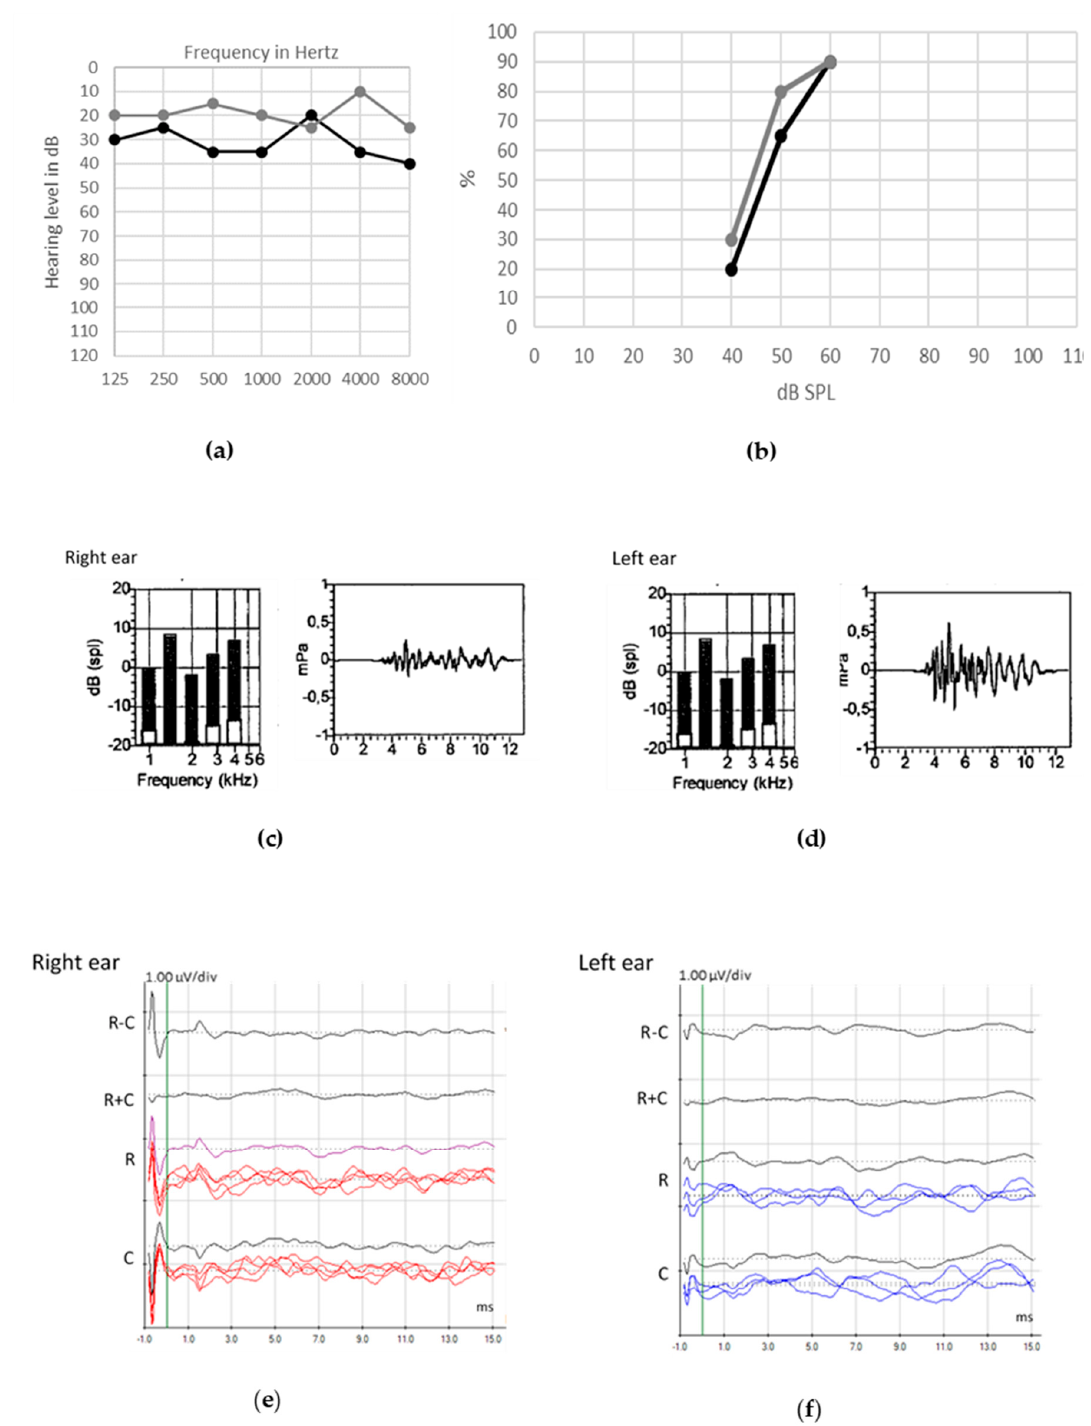
Figure 4. Audiological assessment in an adult patient with auditory neuropathy spectrum disorder (ANSD) and bilateral cochlear nerve atrophy. Unaided thresholds for pure-tone audiometry (( a ), black line for right ear, gray line for left ear) and speech audiometry (( b ), black line for right ear, gray line for left ear) in quiet are good. Otoacoustic emissions (OAEs) are present bilaterally in both temporal/intensity recordings (left panel in ( c ) for right ear, left panel in ( d ) for left ear) and spectral analysis (right panel in ( c ) for right ear, right panel in ( d ) for left ear); on the other hand, auditory brainstem responses (ABRs) are abnormal with no clear cochlear microphonic (CM) (( e ) for right ear, ( f ) for left